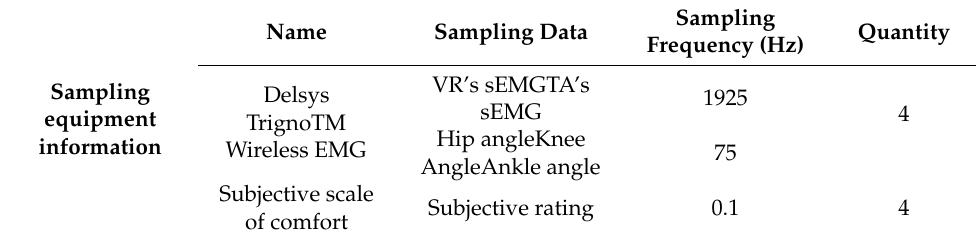
Table 2. Test equipment